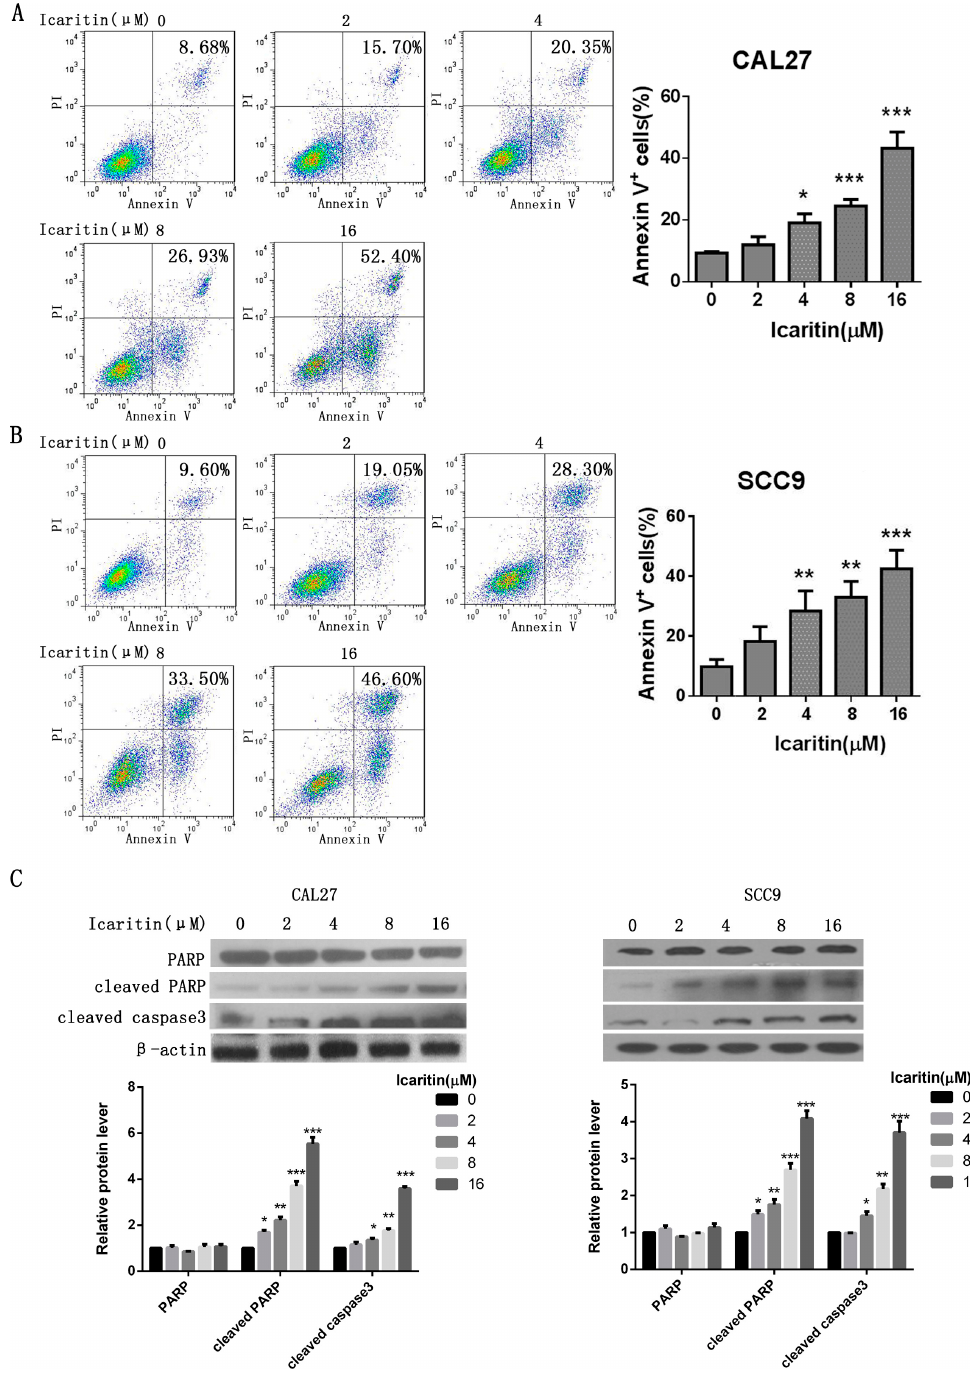
Figure 3. Icaritin induced apoptosis in OSCC cells. ( A , B ) OSCC cell apoptosis after icaritin treatment. CAL27 and SCC9 cells were treated with icaritin at indicated doses for 48 h, then were harvested and stained with Annexin-V FITC and PI. Annexin-V positive cells were measured by flow cytometry. Columns represent the average percent of Annexin V positive cells. Data were expressed as mean ± SD ( n = 3, in triplicate). * p < 0.05; ** p < 0.01, *** p < 0.001. Representative images were shown in the left panel; ( C ) Effects of icaritin on apoptosis related proteins, total and cleaved PARP, and cleaved caspase 3. β -actin was used as a loading control. Relative density data of each protein was quantified by β -actin using Image J, and the data represented the mean of three independent experiments. * p < 0.05; ** p < 0.01; and *** p < 0.001 versus 0 μ M group.